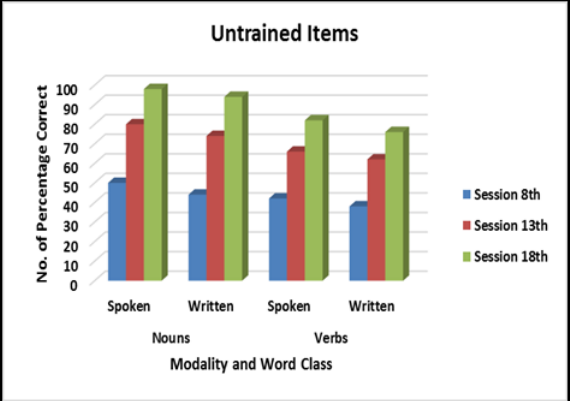
Figure 5. Performance of untrained nouns and verbs in spoken and written naming at each baseline in English.